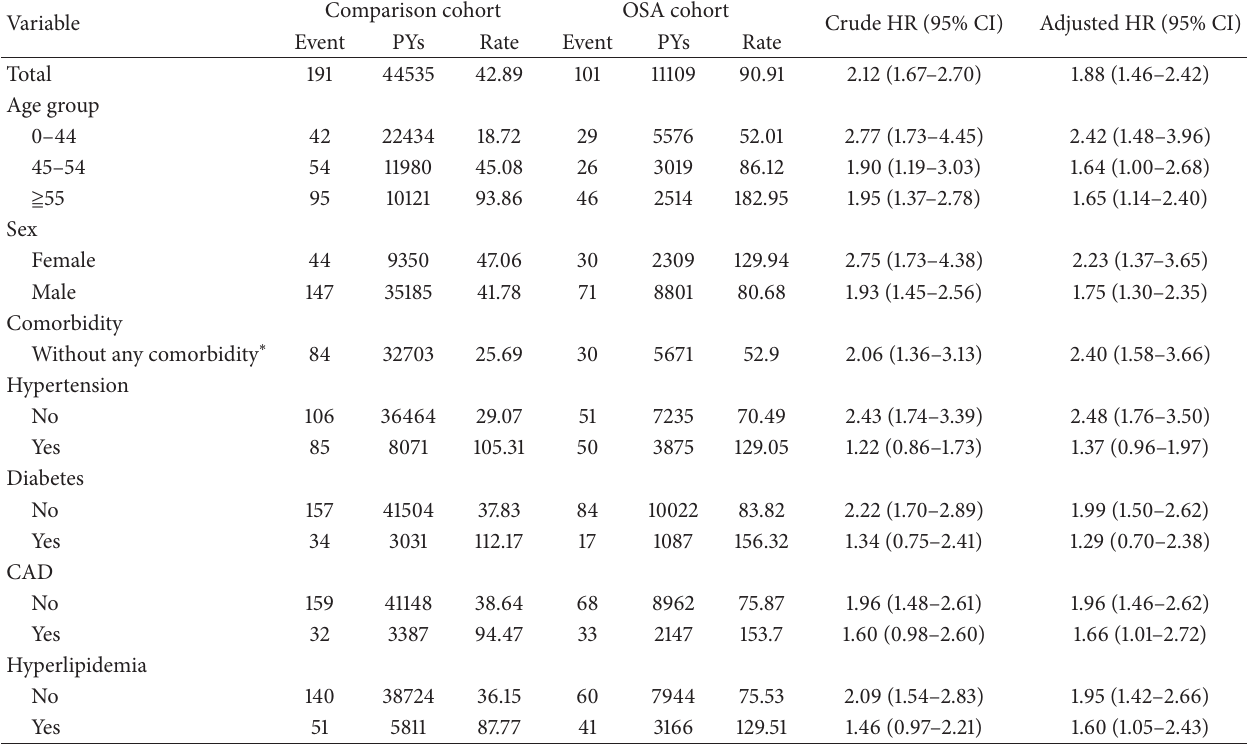
Table 2: Incidence rates of glaucoma and multiple Cox regression model measured hazard rates ratio between two study cohorts.